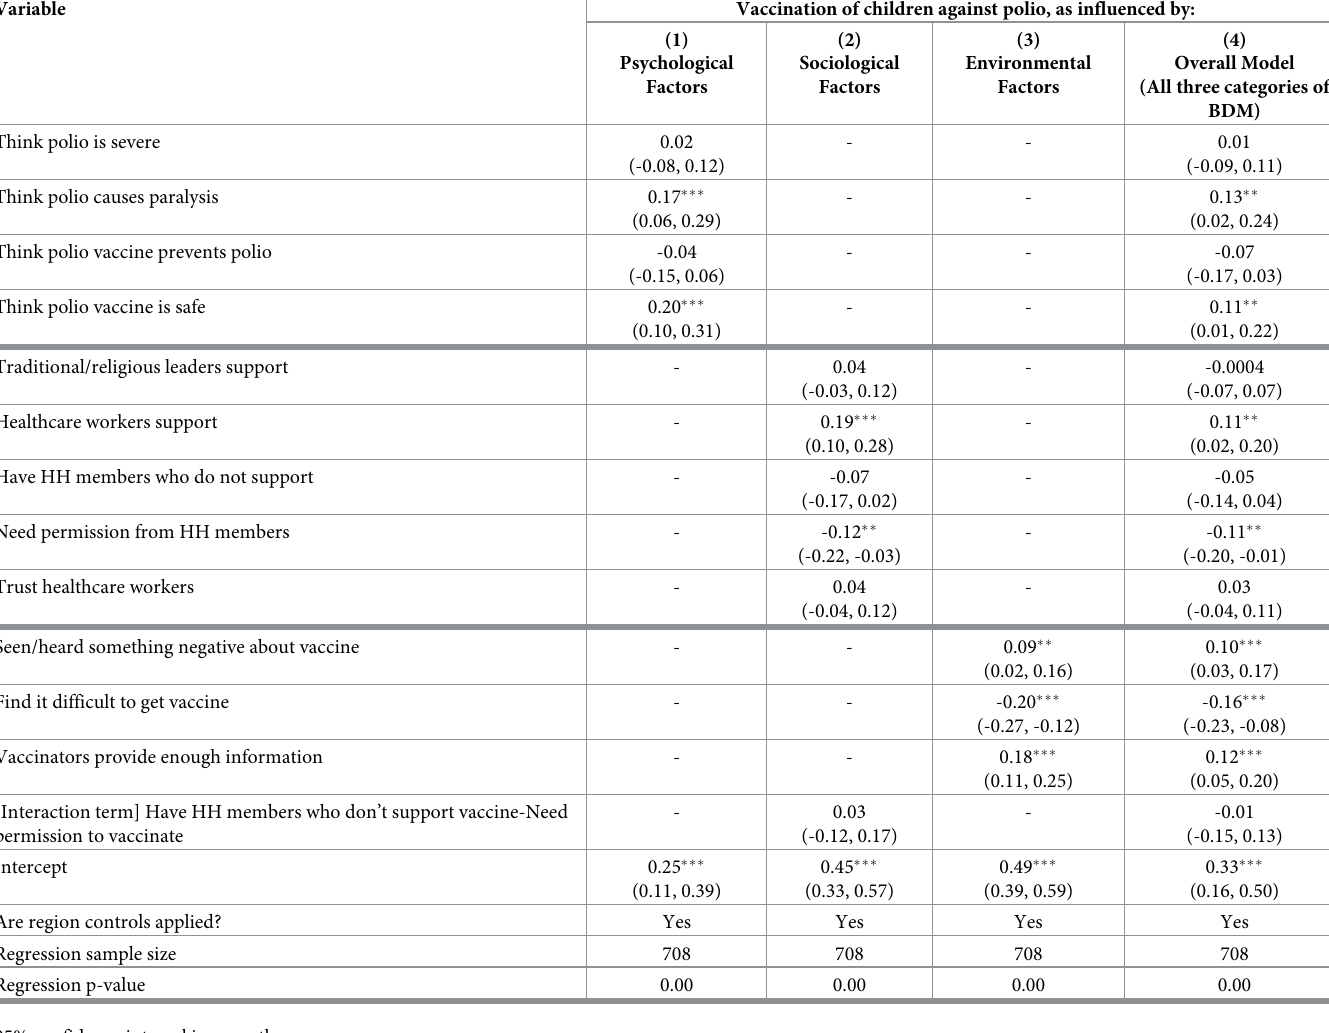
Table 3. Linear probability model on psychological, sociological, and environmental factors, as per BDM, that exert influence on whether a child has already been vaccinated against polio (i.e. vaccine uptake).